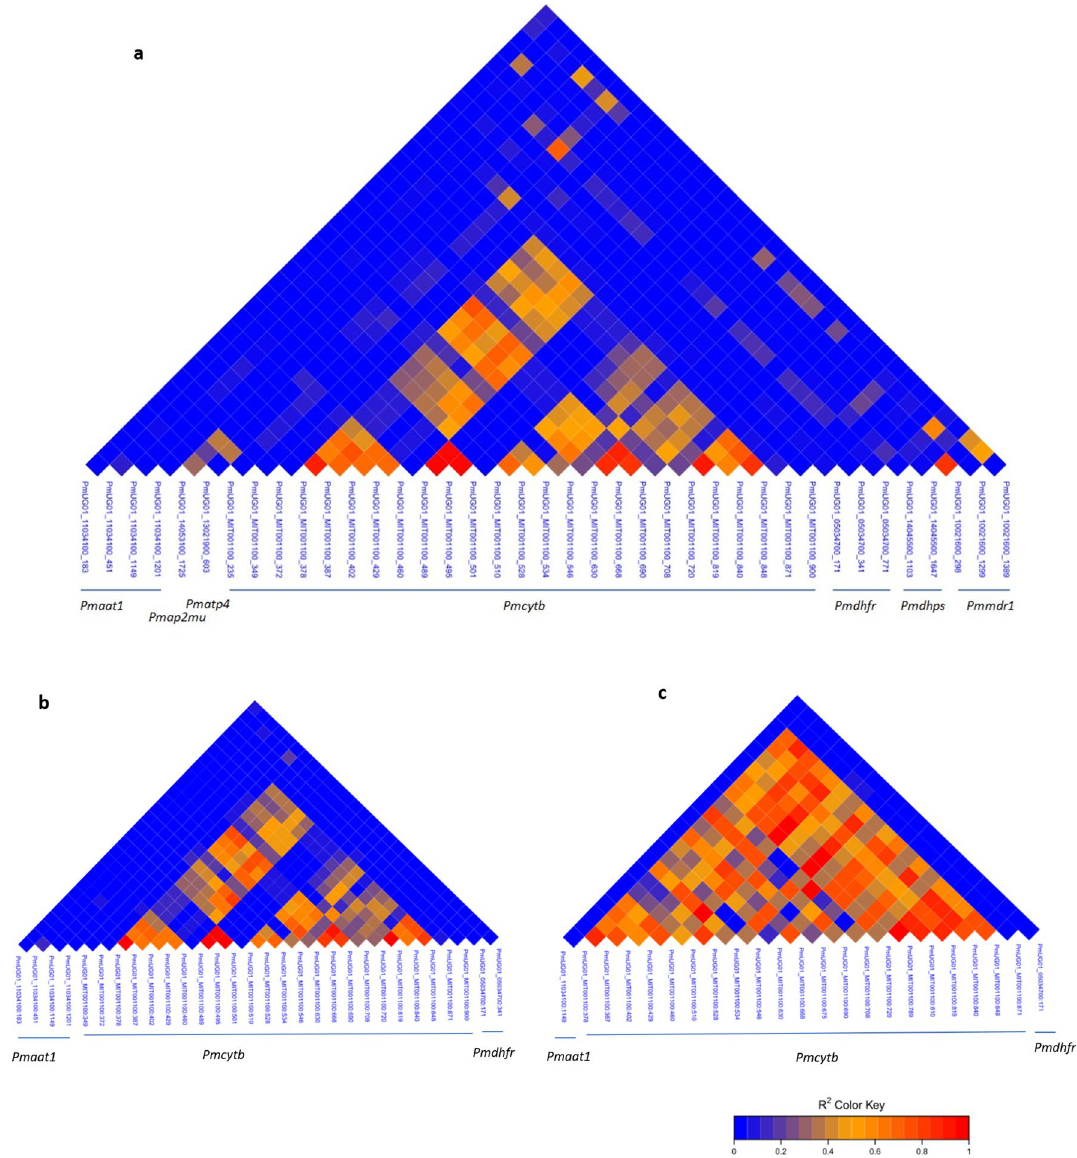
Figure 6. Linkage disequilibrium between SNPs of orthologous drug resistance genes computed from ( a ) unfiltered data, ( b ) data filtered for missingness and ( c ) denoised and filtered